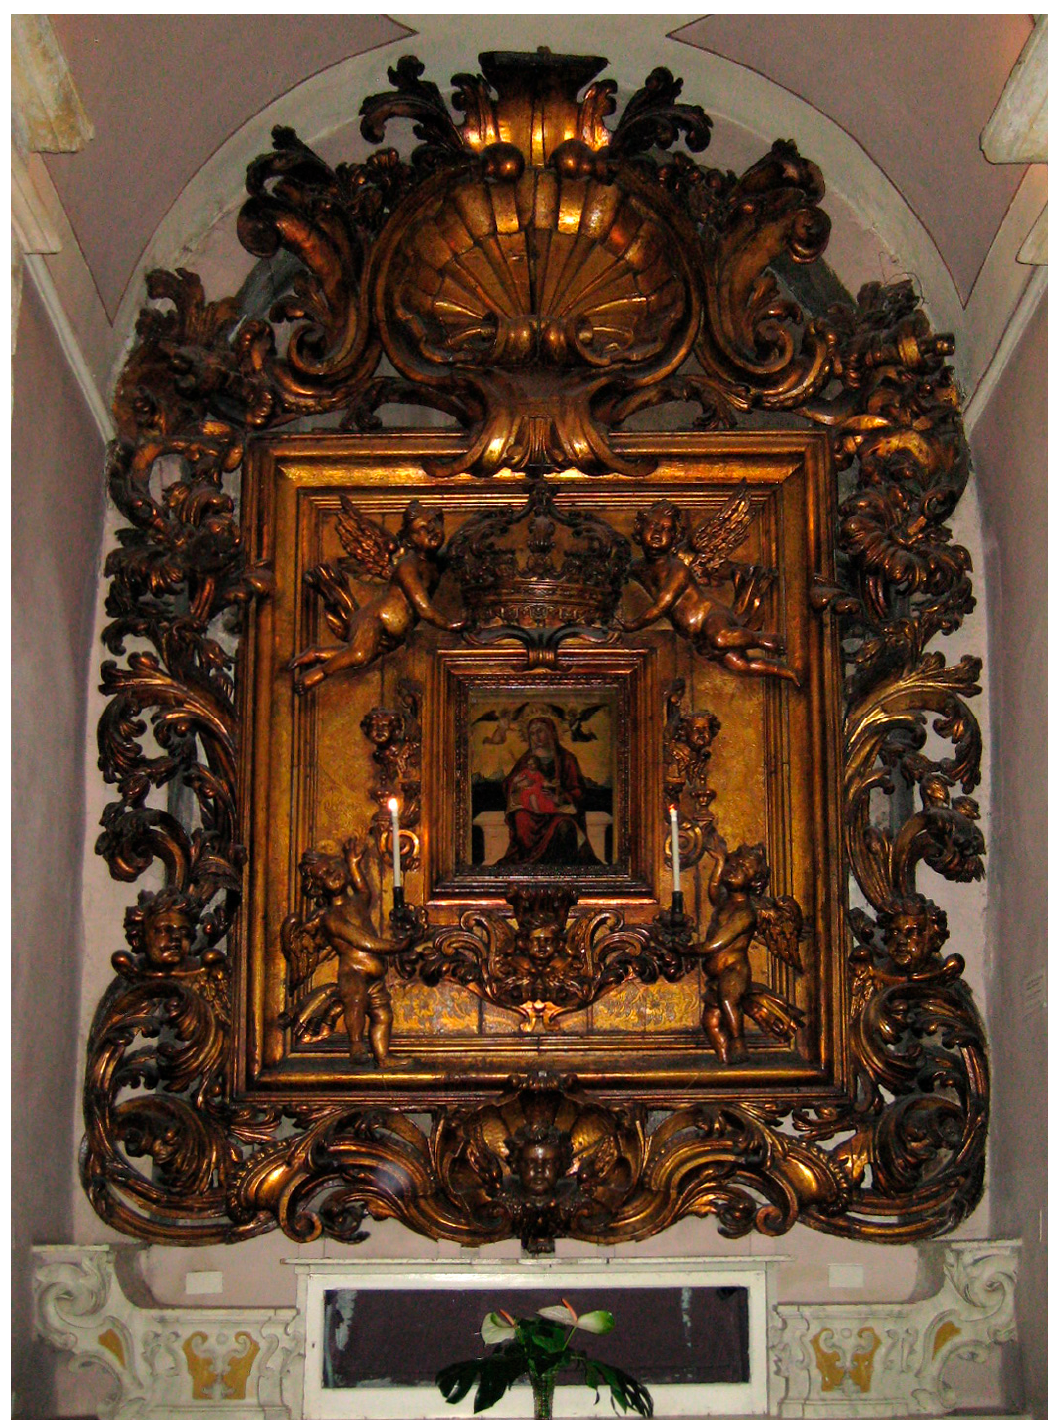
Figure 20. Madonna and Child Enthroned (Madonna di Costantinopoli), Bisceglie, Church of Saint Matthew (Chiesa di San Matteo) (photograph by the author). (Chiesa di San Matteo) (photograph by the